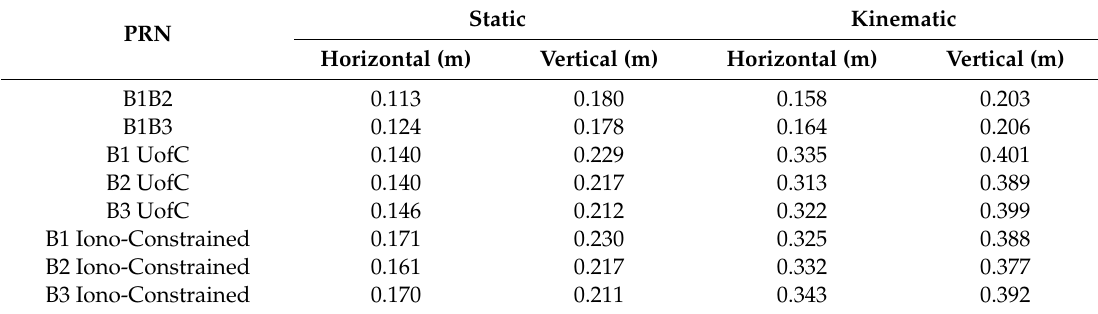
Table 5. Root mean square (RMS) of BDS SBAS corrections-based DF- and SF-PPP of di ff erent schemes. Static Kinematic PRN Horizontal (m) Vertical (m) Horizontal